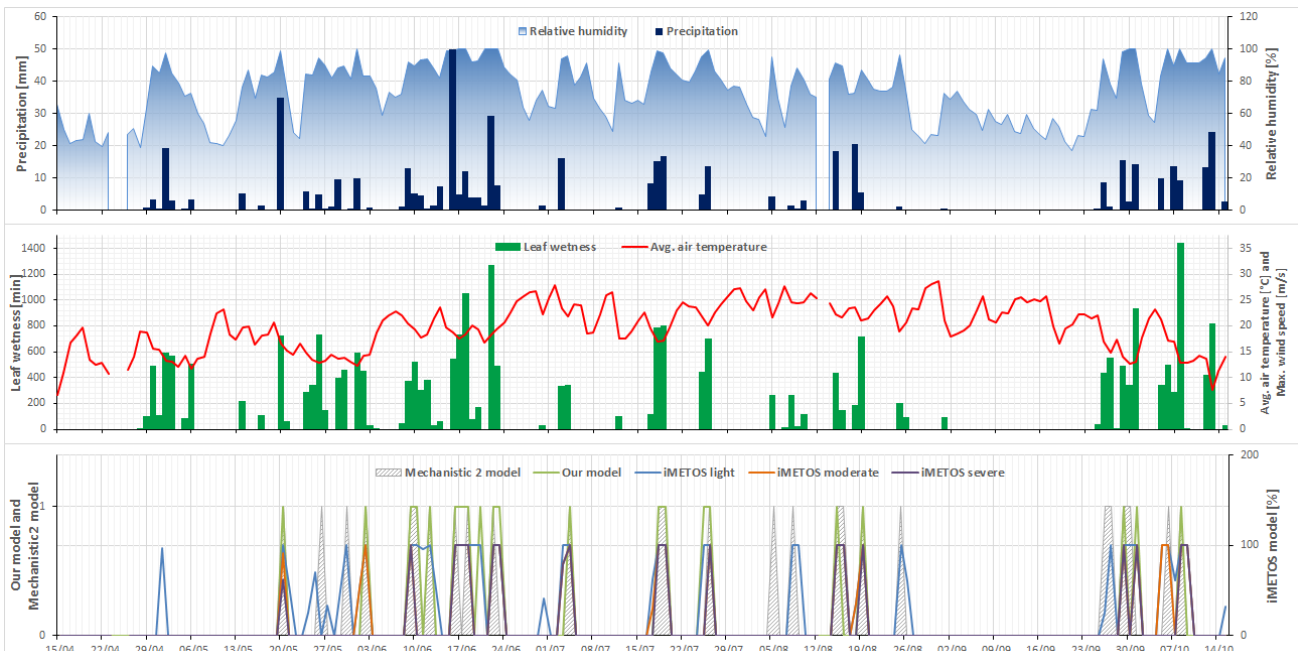
Figure 17. Secondary infection alarms for the location ’Vršaˇcki vinogradi’.